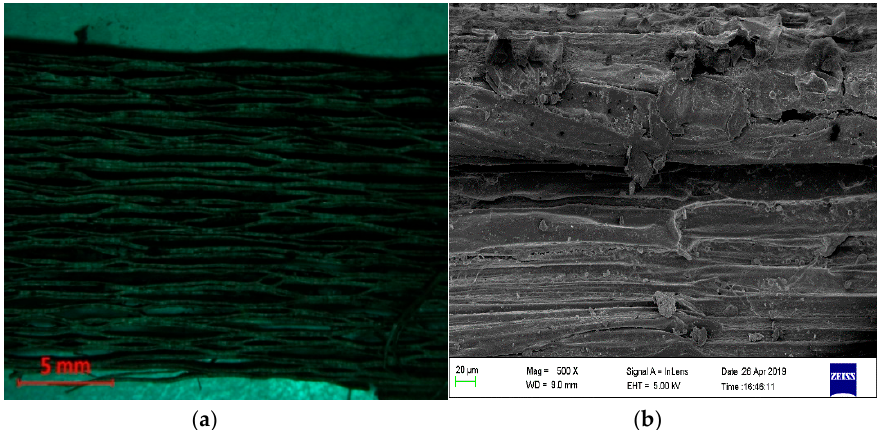
Figure 3. (a , b ) Optical and SEM representation of untreated linearly structured pawpaw fiber.